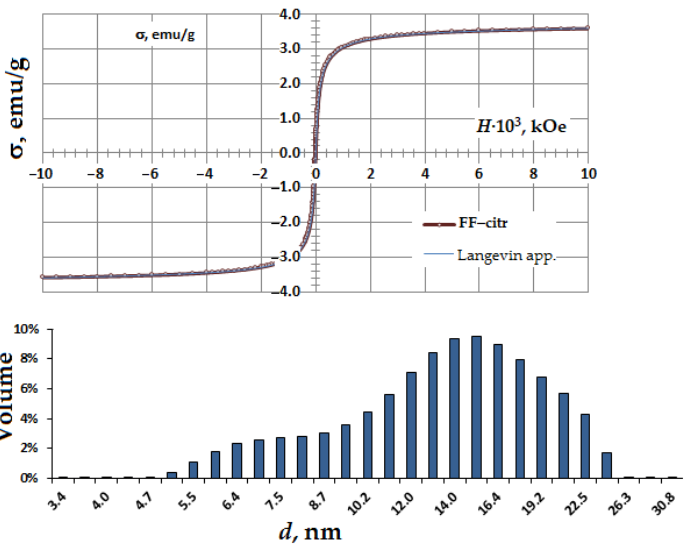
Figure 1 . Magnetization curve and size distribution histogram of the obtained superparamagnetic γ -Fe 2 O 3 –citr magnetic γ -Fe 2 O 3 – citr magnetic nanoparticles.